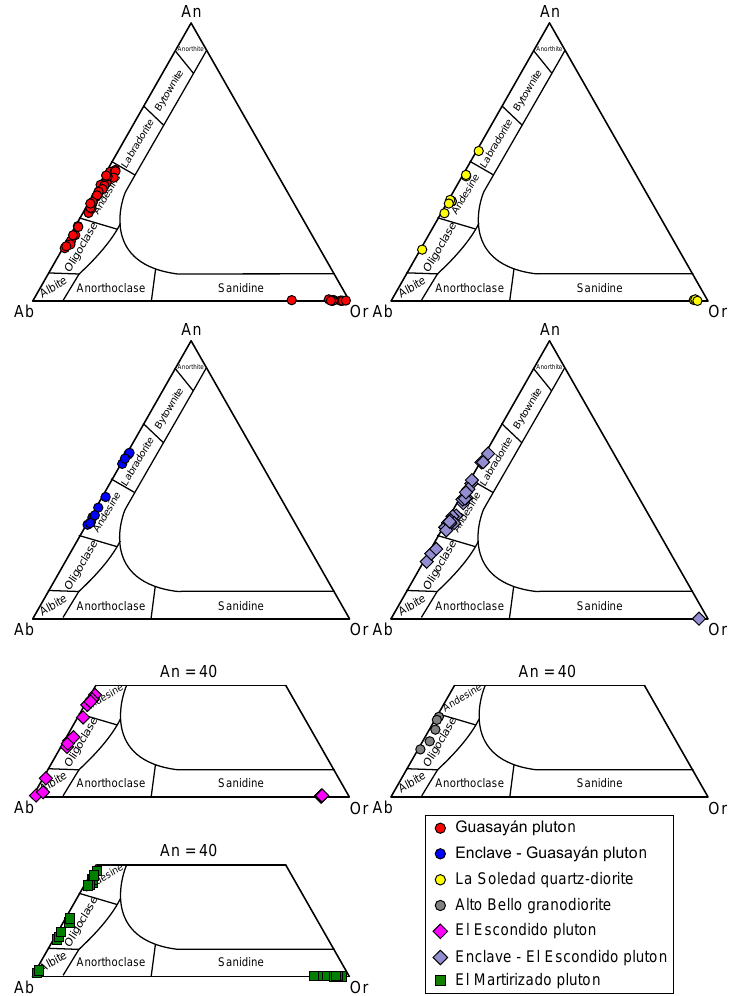
Figure 4. Composition of feldspars from the granitoids of the Sierra de Guasayán. An–Ab–Or diagram (data in mol%). Abbreviations: Ab, albite; An, anorthite; Or, orthoclase. Plagioclase from the El Escondido pluton showed cores of andesine (An 33–37 ) and rims of oligoclase (An 18–29 ) that occasionally had an external rim of albite (Ab 92–99 ) (Figure 4; Table S1). Plagioclase in the mafic enclave (GUA 23026) had more calcic compositions than